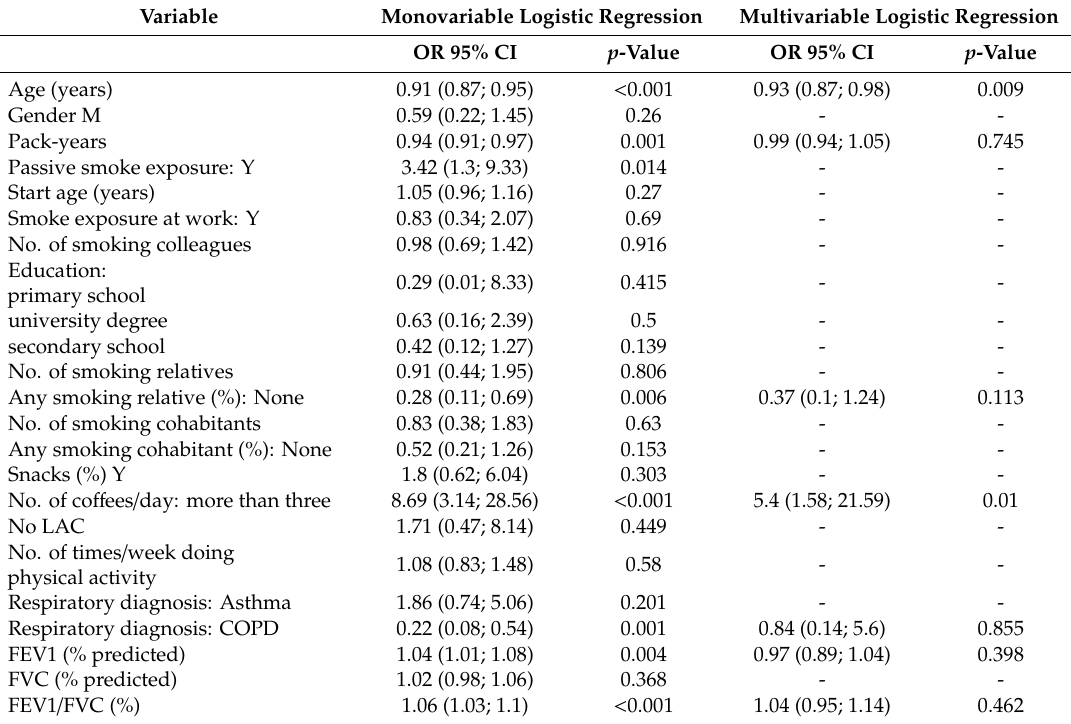
Table 5. Monovariable and multivariable logistic regression estimate (OR 95% CI) in patients with at least one previous attempt to quit smoking according to success or relapse. Monovariable Logistic Regression Multivariable Logistic